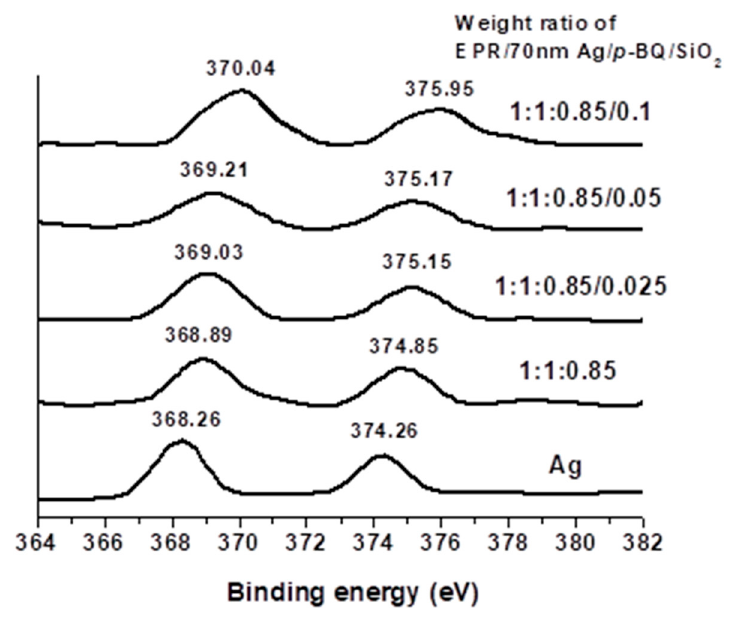
Figure 4. Binding energies for the silver metal in EPR/Ag nanoparticles/ p -BQ with varying contents of silica